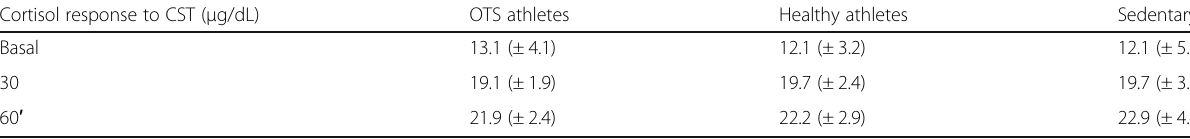
Table 1 Mean (±SD) basal serum cortisol and response to a cosyntropin stimulation test (CST) with 250 μ g of synthetic ACTH Cortisol response to CST ( μ g/dL)